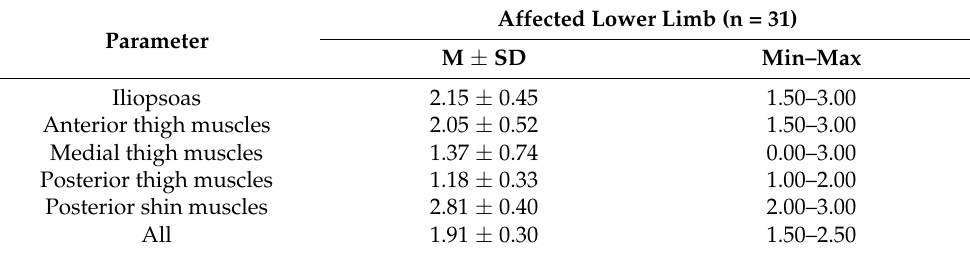
Table 6. Descriptive characteristics of the degree of spasticity of the affected lower limbs of children in the tested